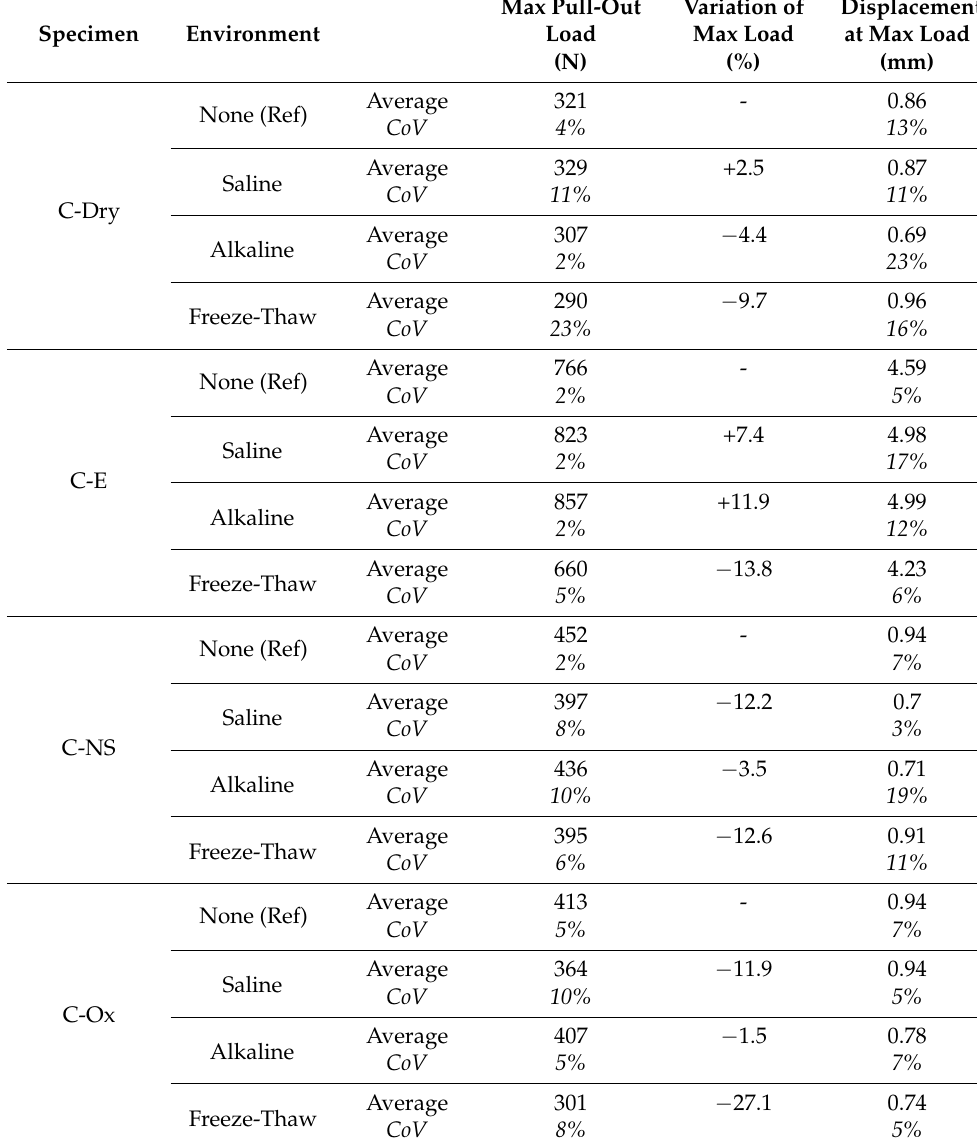
Table 5. Results of pull-out tests of carbon yarns subjected to different aging